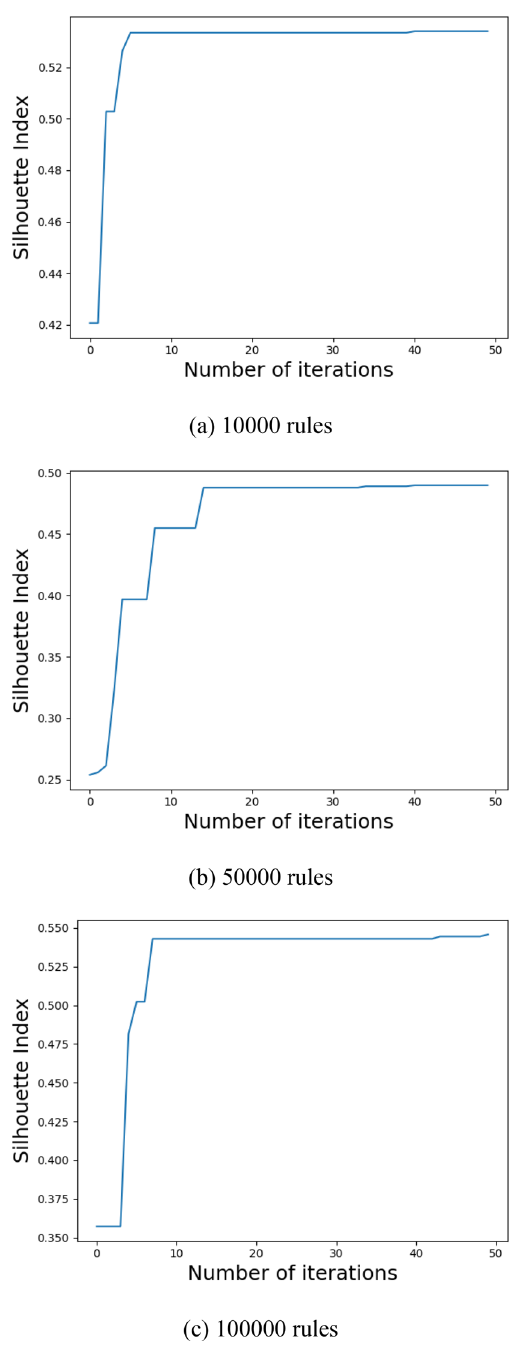
Figure 8. Parameter optimization on ASMS policy